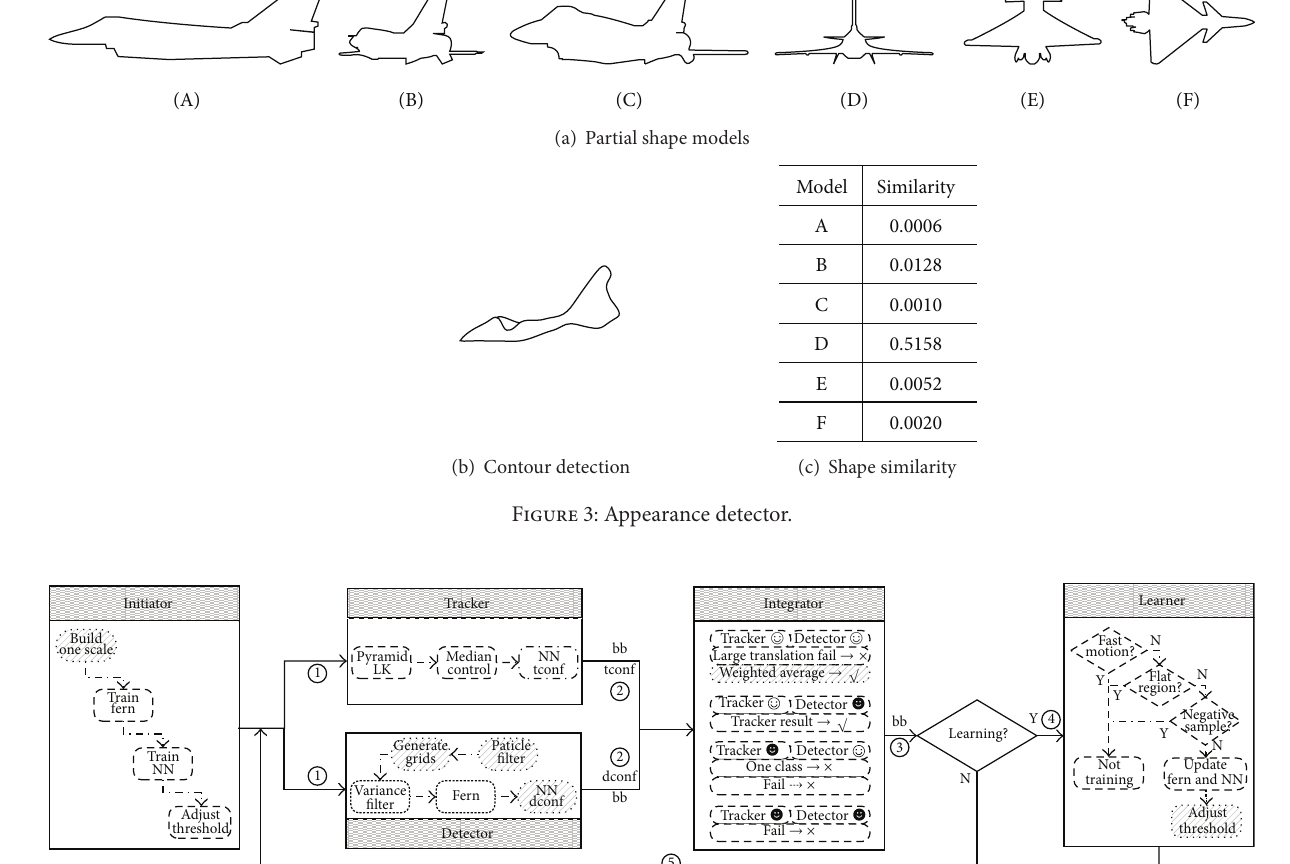
Figure 2: Motion detector.